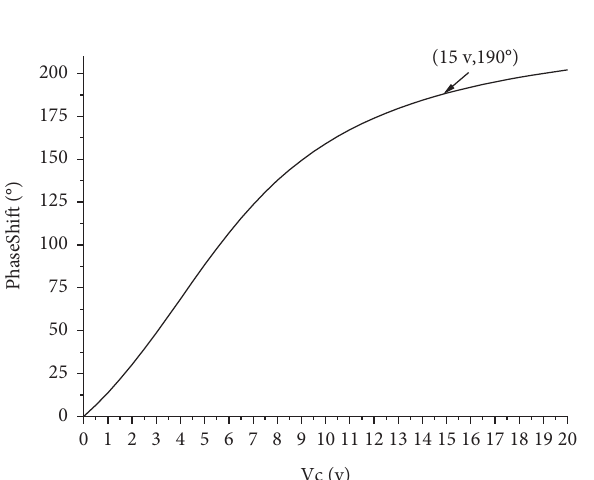
Figure 6: Phase shift of reflection phase shifter with loading voltage.